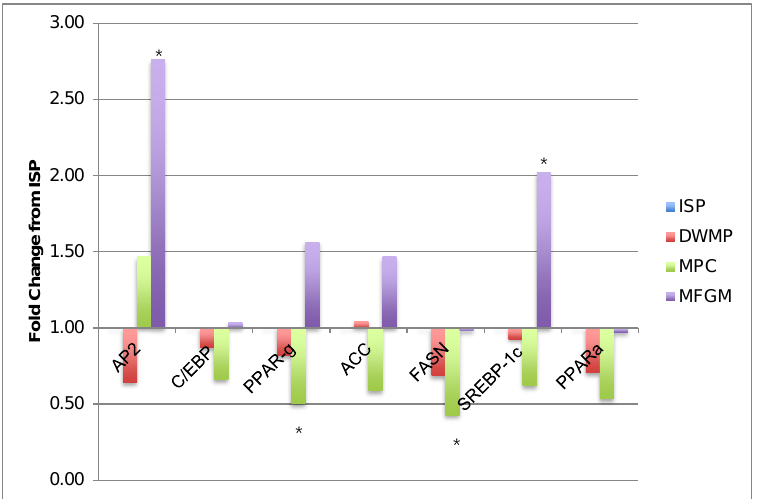
Figure 4. Intestinal gene expression: adipocyte differentiation and lipogenesis. Gene expression data from small intestines of n = 5/diet; fold increases were considered significant if at least 2-fold different from the ISP comparator and are denoted by the use of “*”. AP2 was increased 2.75-fold and SREBP-1c increased 2-fold in intestines from MFGM-fed mice compared to ISP. Intestines of milk protein concentrate (MPC)-fed mice showed a 2-fold and 2.3-fold reduction in PPAR-γ and FASN , respectively, relative to ISP. Other adipocyte differentiation and lipogenesis genes were unchanged.